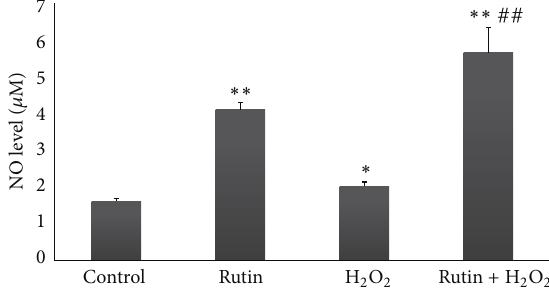
Figure 1: Bar chart showing eNOS mRNA expression in control, rutin, H 2 O 2 , and rutin + H 2 O 2 groups. Values are expressed as means ± SEM of 𝑛 = 8 . ∗ 𝑃 < 0.05 versus control.